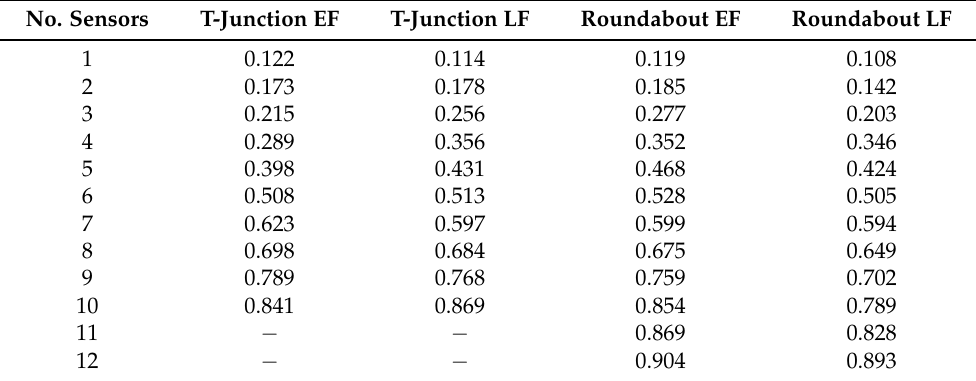
Table 4. Comparative performance analysis considering the MV3D model and various numbers of the active